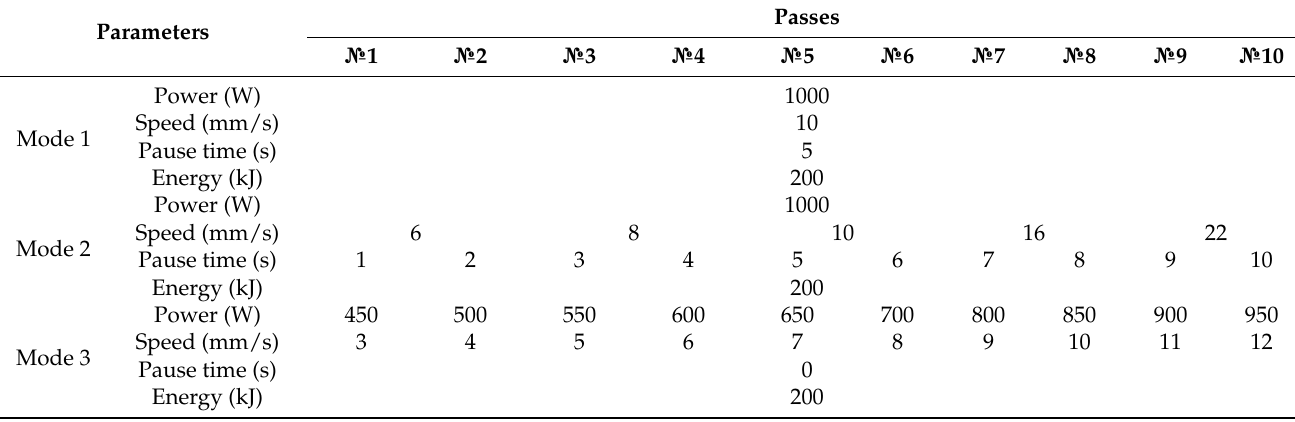
Table 1. Heating mode